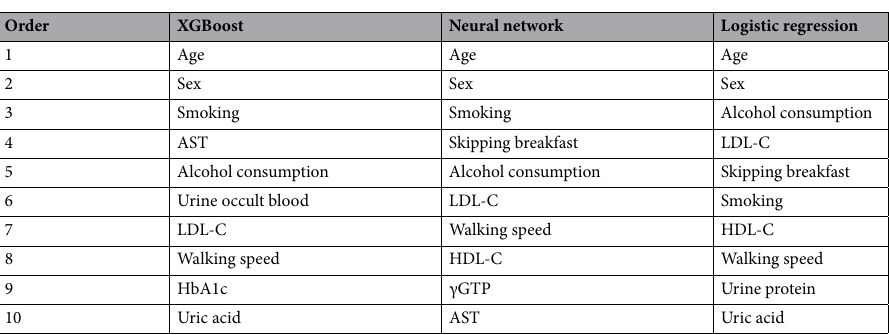
Table 4. Importance ranking of explanatory variables in each model by SHAP values. Mean (standard deviation) or number (%). AST aspartate aminotransferase, LDL-C low-density lipoprotein cholesterol,